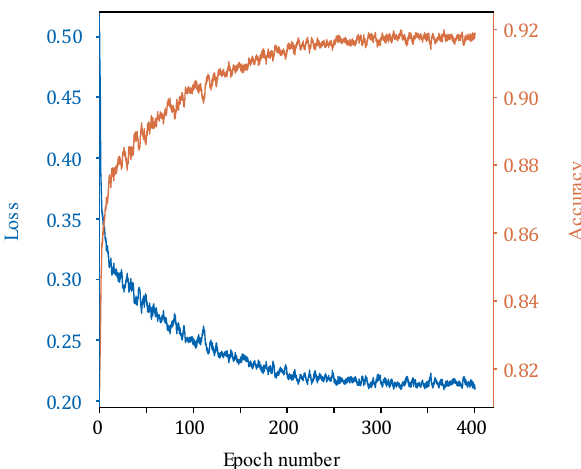
Figure 2. Evolution of the point-wise cross-entropy loss and the overall training accuracy with the epoch number for the training of KPConv using transfer learning. This model is tested using the railway tunnel sections, as defined in Section 3.1. Table 2 provides the confusion matrix of the semantic segmentation results of KPConv using transfer learning with the default parameters. This table shows that, overall, most of the points are correctly classified. The rails category shows the greatest discrepancies with of the ground truth (GT) rail points being classified as ground. 31%